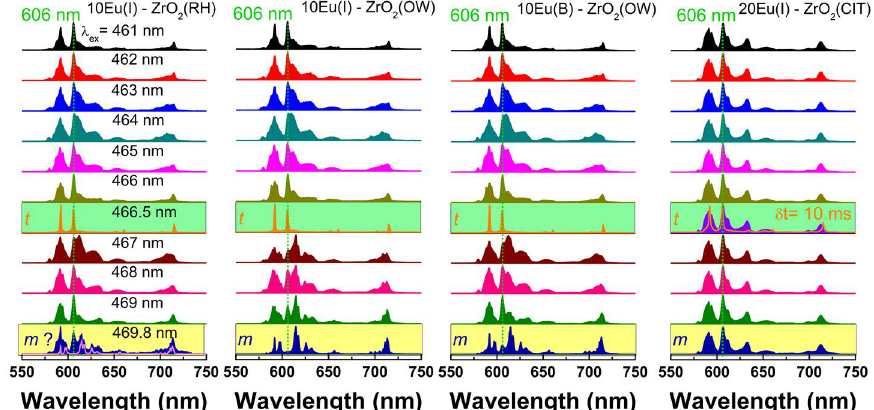
Figure 3. Comparison between the site-selective emission spectra of 10Eu(I)–ZrO 2 (OW, RH) and 20Eu(I)–ZrO 2 (CIT) performed at low temperature (T = 80 K). For comparison only, a selection of emission spectra of 10% Eu bulk doped using the OW method and labelled as 10Eu(B)–ZrO 2 (OW) is also included. The dotted green line highlights the appearance of the tetragonal fingerprint emission (defined by the 606 nm peak). The green highlighted spectra correspond to well-separated tetragonal emission. The yellow highlighted spectra represent the contribution from the monoclinic fingerprint mission.